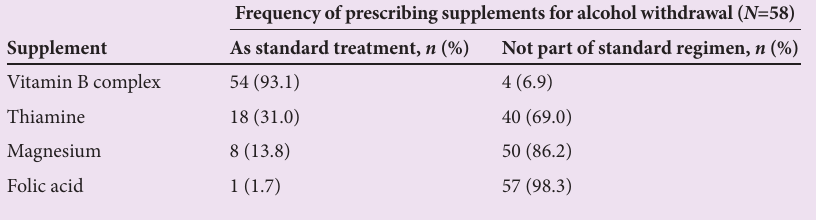
Table 6. Prescription of vitamin and mineral supplementation during alcohol with drawal